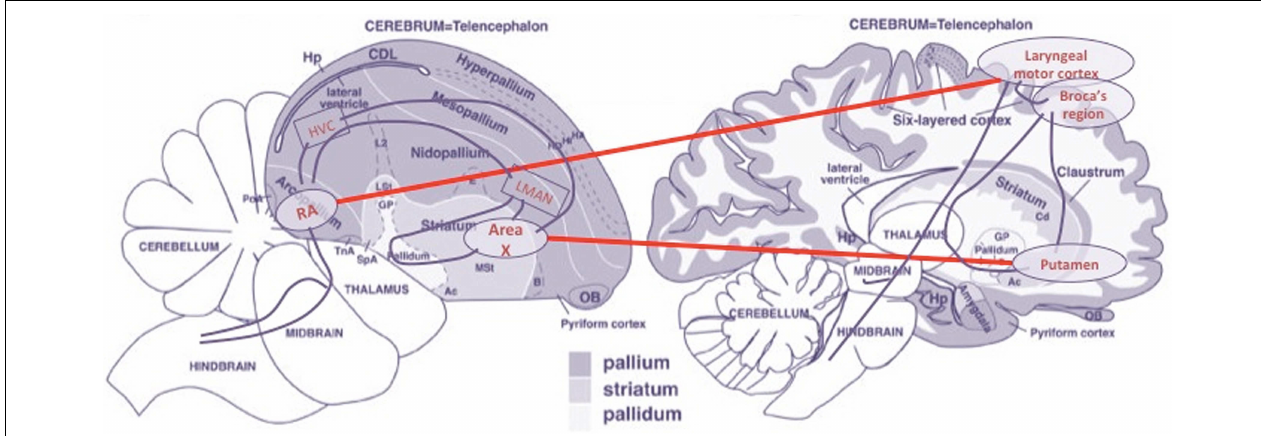
FIGURE 4 | Main morphological alignments of brain components of the birdsong and language circuits. Based on an image from Reiner et al. (2004). ( Figure 1 ), reproduced with permission of John Wiley and Sons,